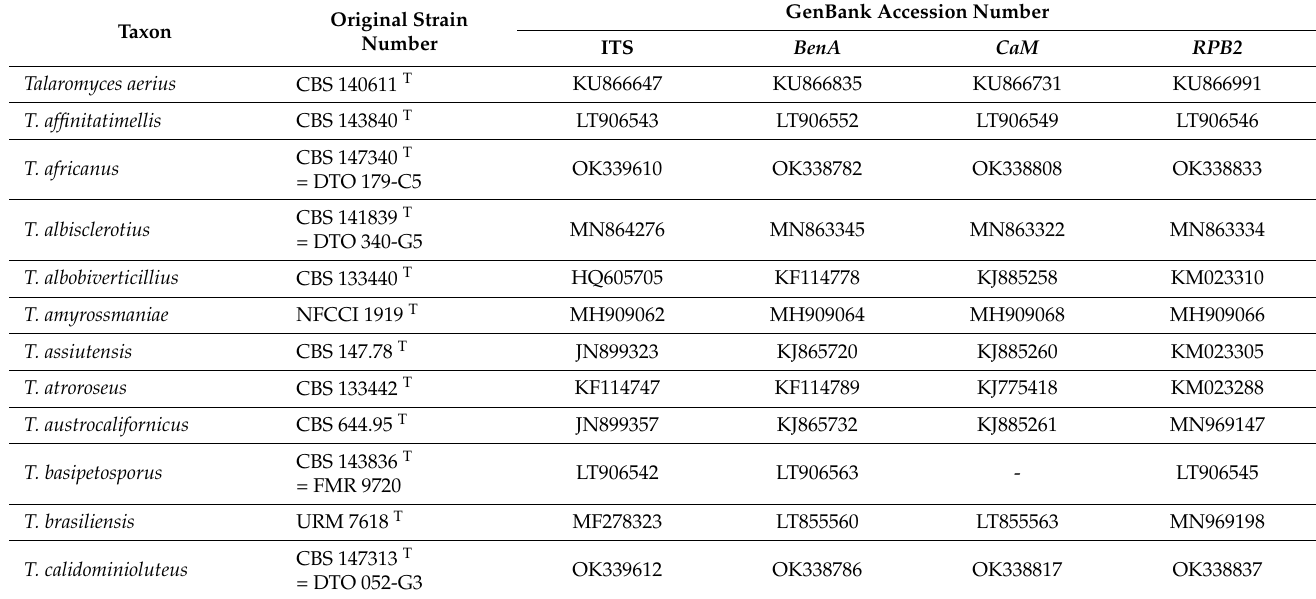
Table 2. Talaromyces species of sect. Trachyspermi used in phylogenetic analyses and their GenBank accession